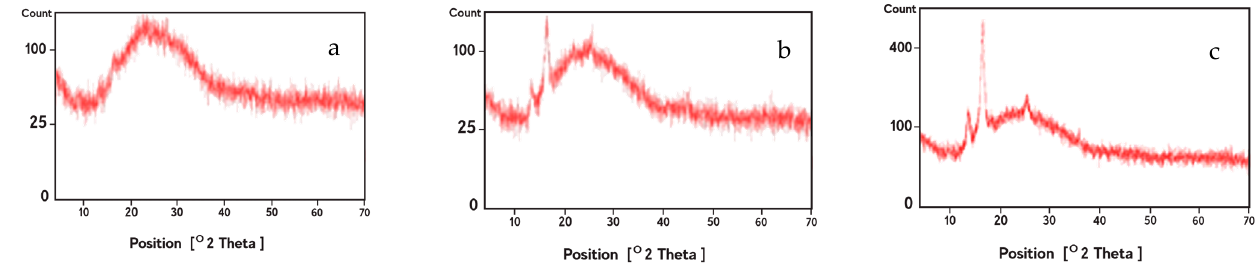
Figure 4. XRD analysis of ( a ) crosslinked gelatin nanofibers scaffolds before plasma treatment, ( b ) nanofibers after argon plasma treatment and ( c ) nanofibers after argon–oxygen plasma